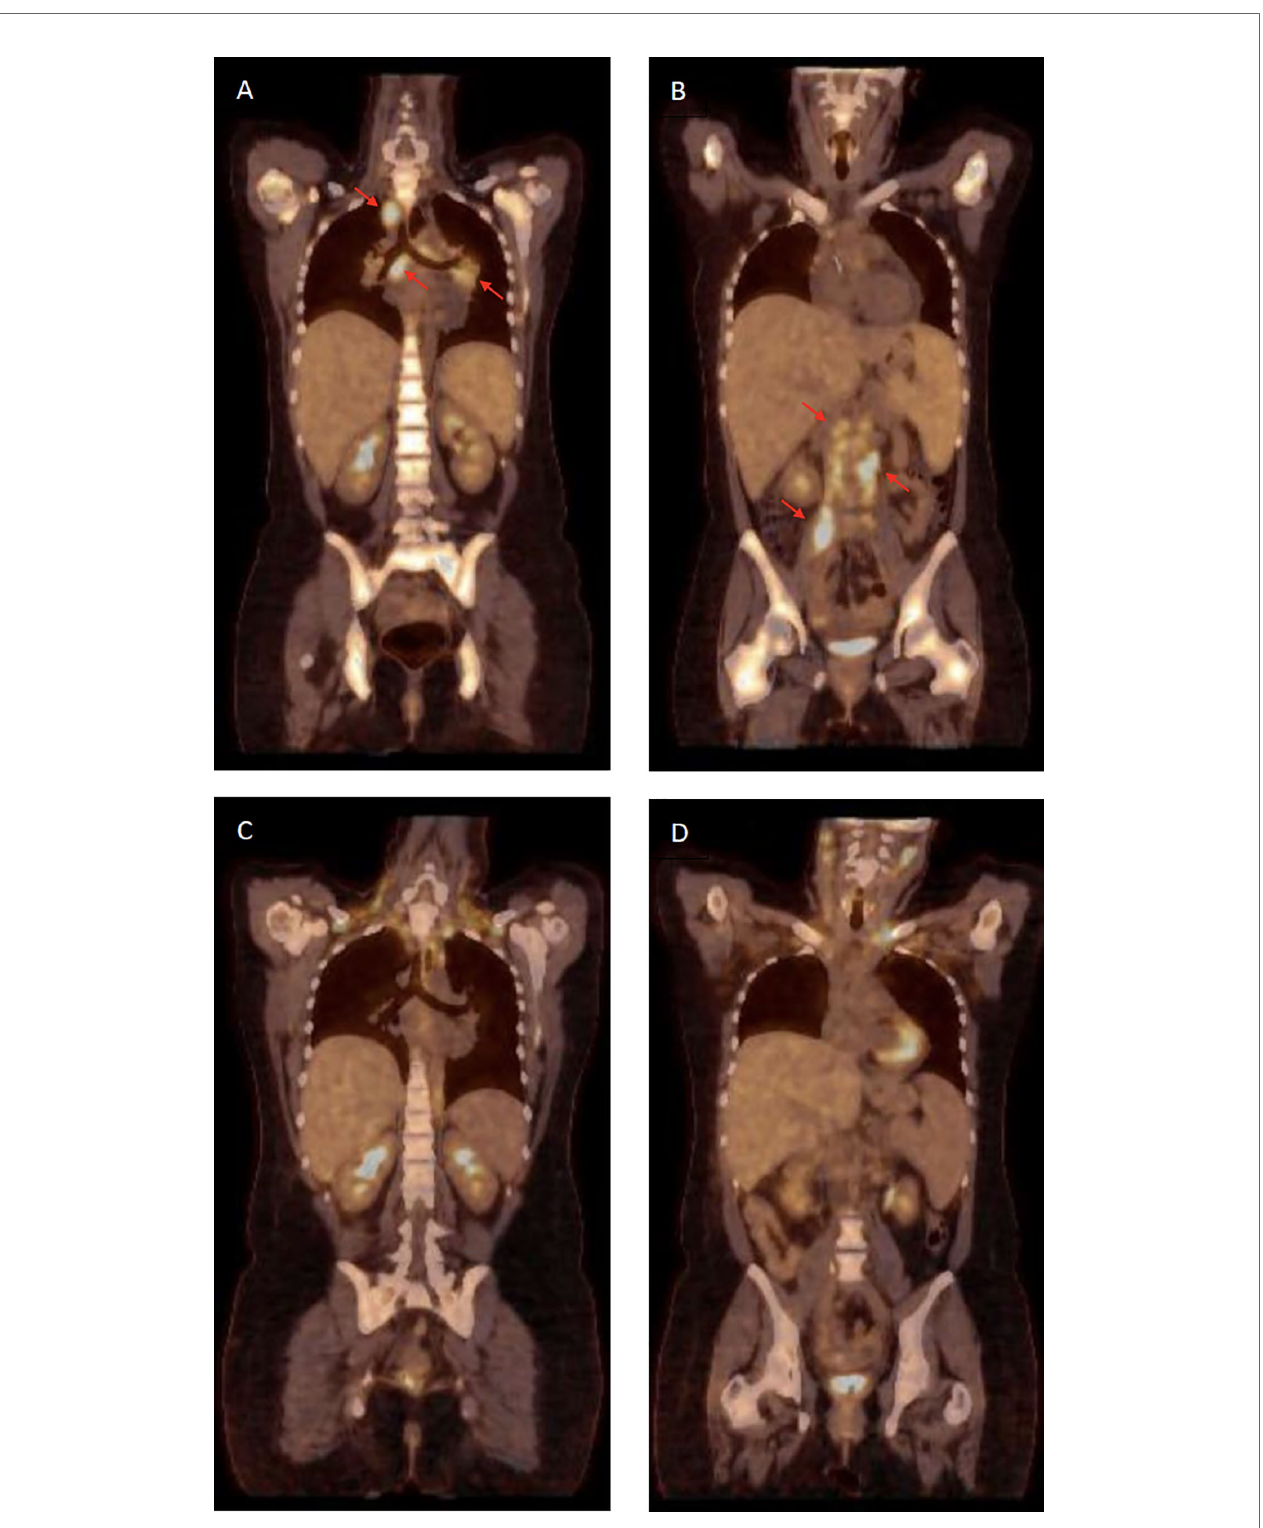
FIGURE 1 | Positron emission tomography – computed tomography (PET-CT). (A, B) Disseminated lymphadenopathy due to non-tuberculous mycobacterial (NTM) infection (red arrows) and bone-marrow activation and hepatosplenomegaly due to hemophagocytic lymphohistiocytosis (HLH) at diagnosis. (C, D) Control PET-CT following allogeneic hematopoietic transplantation (day +240) and after 12 months of tuberculostatic therapy demonstrating complete remission of NTM-related lymphadenopathy and remission of HLH-associated hematopoietic